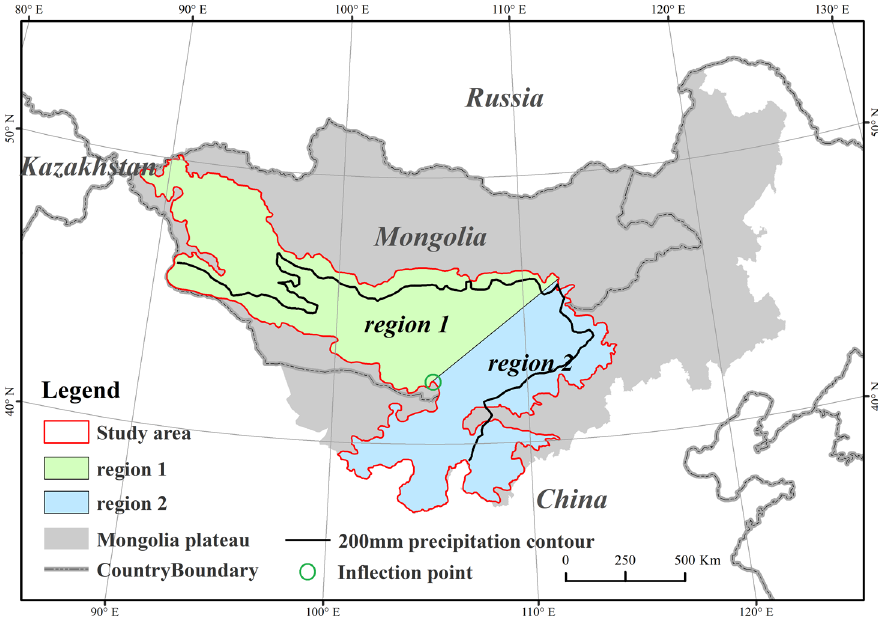
Figure 1. Location of the study area. The vegetation greenness line of Region1 is roughly parallel to the latitude line, and Region 2 is roughly parallel to the longitudinal line.